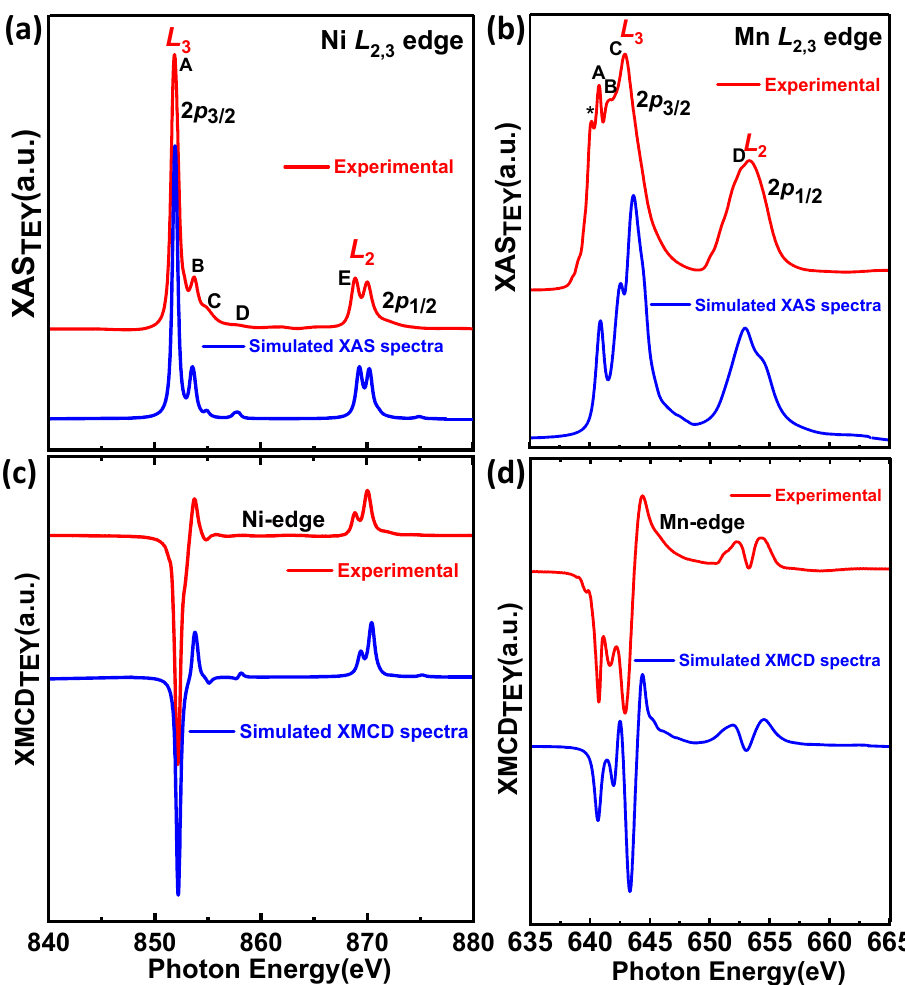
Figure 8. Calculated and experimental XAS ( a , b ) and XMCD ( c , d ) across Ni ( a , c ) and Mn ( b , d ) L 2,3 edges ( O h symmetry, blue lines). The experimental spectra of the PNMO/STO-(A) sample (red lines) are shown for